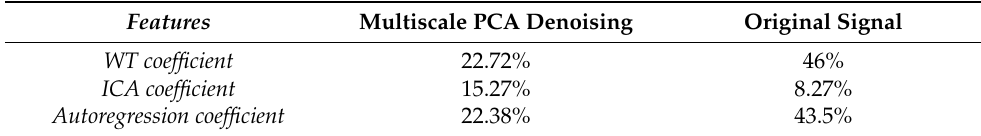
Table 4. Classification with the naïve Bayesian method.